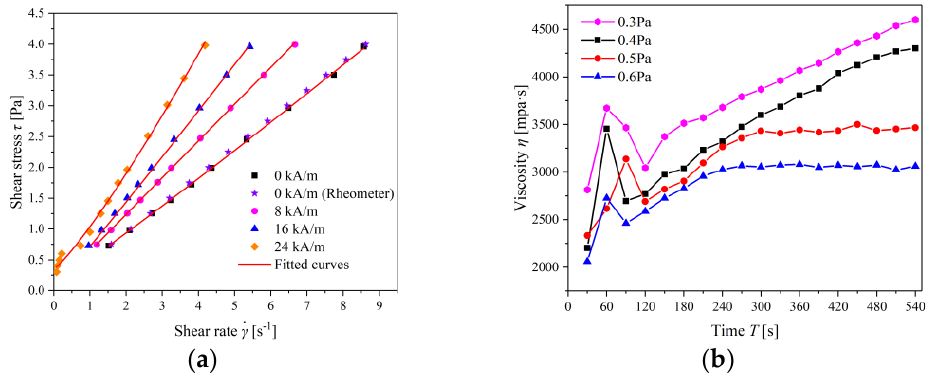
Figure 8. Comparison of lab-made magnetic fluid flow curves: ( a ) flow curve of magnetic fluid and fitted curves under different magnetic flux densities by the novel measuring system and rheometer and ( b ) change in magnetic fluid viscosity under low shear stress at 24 kA/m by the novel measuring system. Based on the flow curves measured by shear rate or shear-stress sweep, the dynamic yield stress of soft matter is usually determined by fitting on a certain phenomenological rheological model [23]. In experimental rheology, the dynamic yield stress τ 0 of magnetic fluid is most frequently determined by the fitting of the Herschel–Bulkley (H–B)